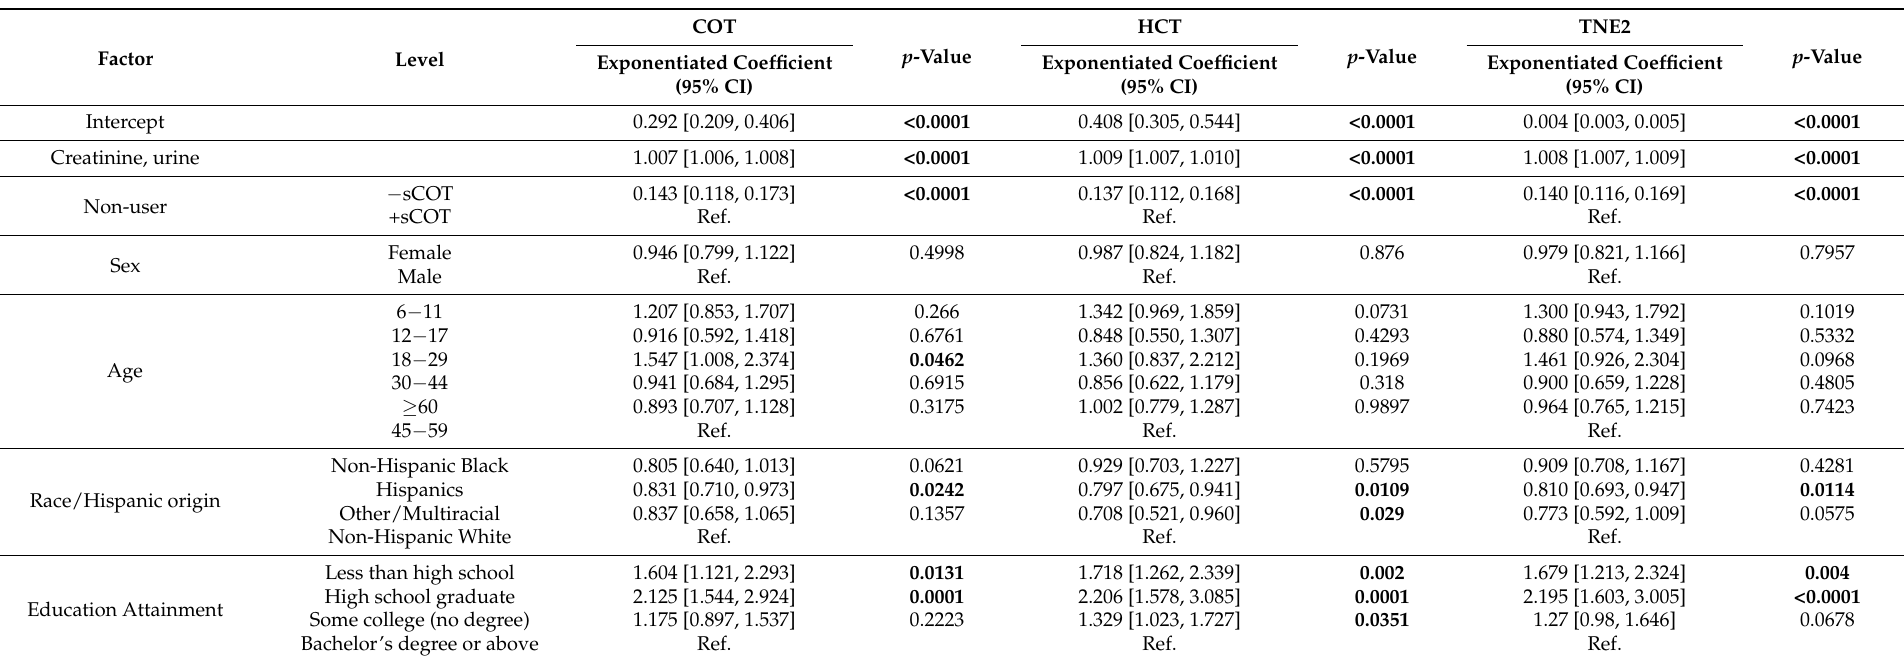
Table 4. Sample-weighted log-linear regression results for urinary cotinine ( µ g/L), trans-3 (cid:48) -hydroxycotinine ( µ g/L) and TNE2 ( µ mol/L) on extent of passive exposure to nicotine and demographic factors among non-users, from NHANES